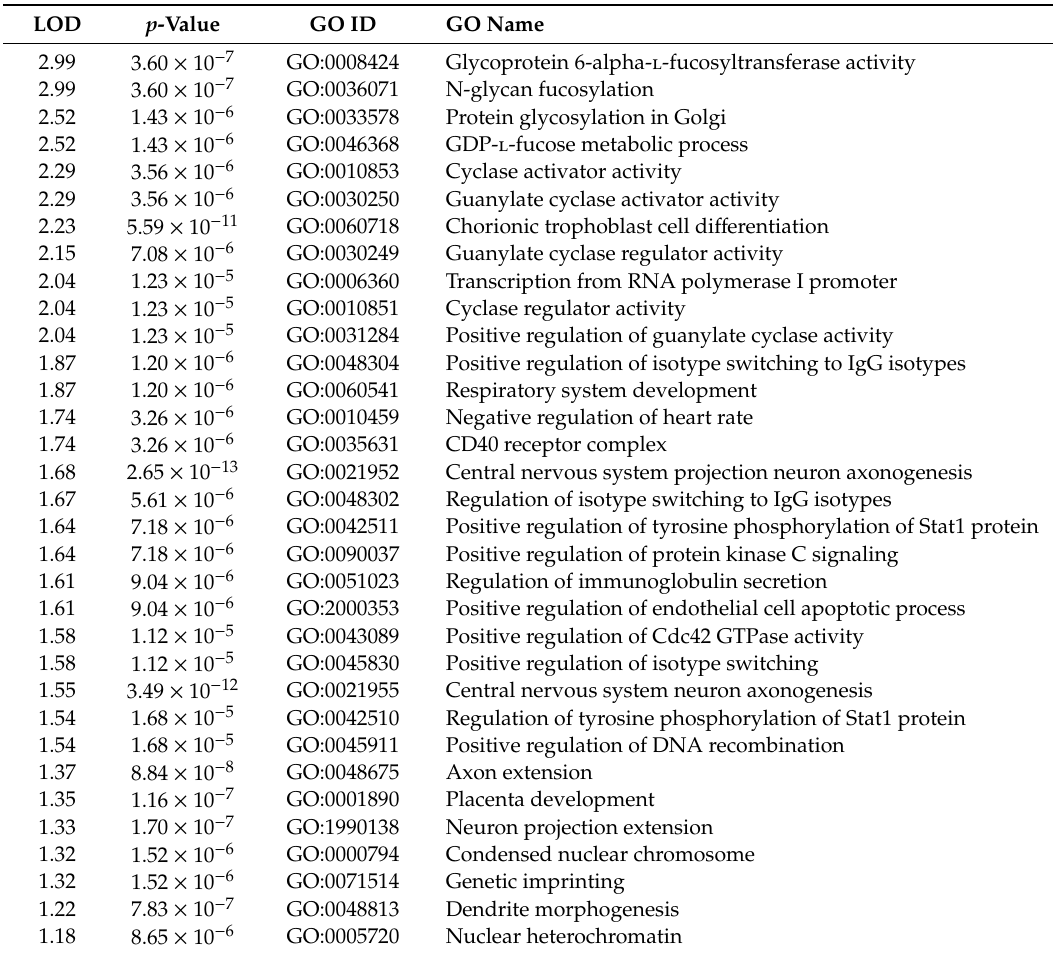
Table A1. Gene function annotation list of up-regulated gene sets in Colon-26MGS, but not in